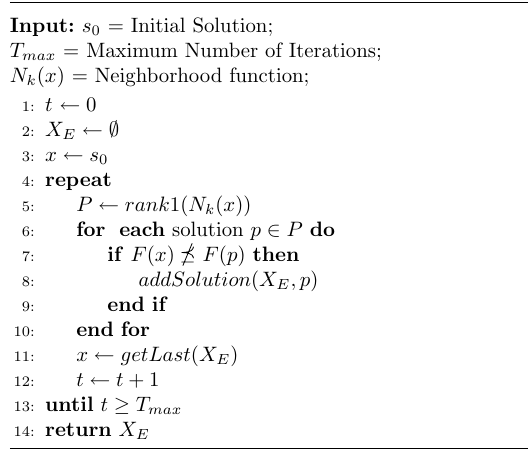
Algorithm 5 Multiple Solutions Hill Climbing: